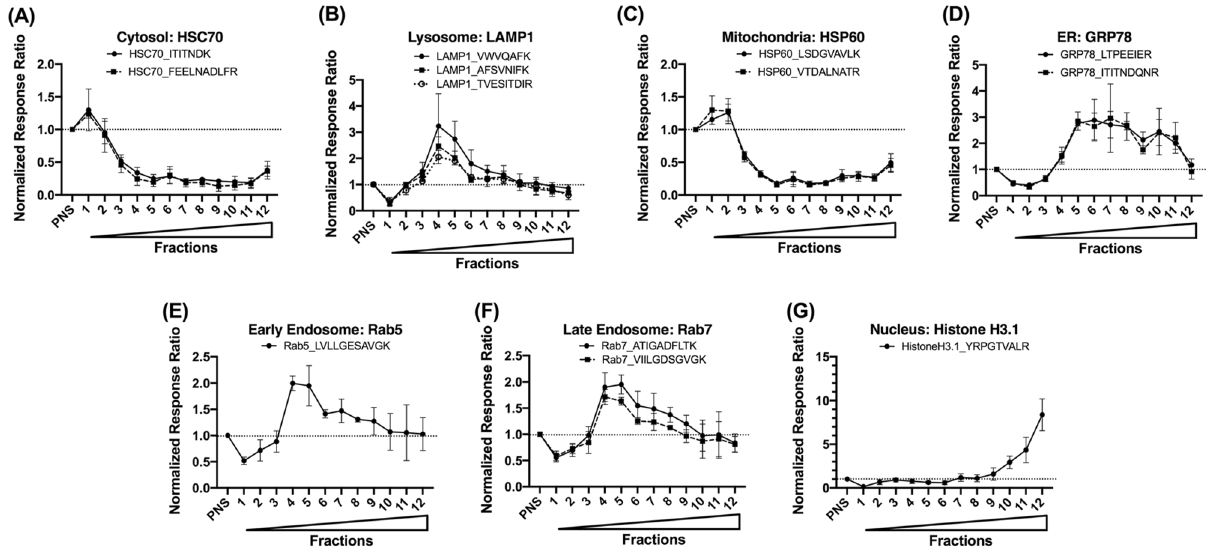
Figure 4. Subcellular organelle marker profiles characterized by UPLC-MRM. 20 µg total protein were digested for each sample. Relative quantification was achieved using response ratio, which corresponds to the ratio of light peptide area to spiked-in heavy labelled peptide area. Each fraction’s response ratio was normalized to its corresponding PNS response ratio. Solid circles, open circles, and squares represent the average normalized response ratio from three human liver donors, and error bars stand for the standard deviation. Wedge indicates increasing sucrose % from fraction 1 to 12.